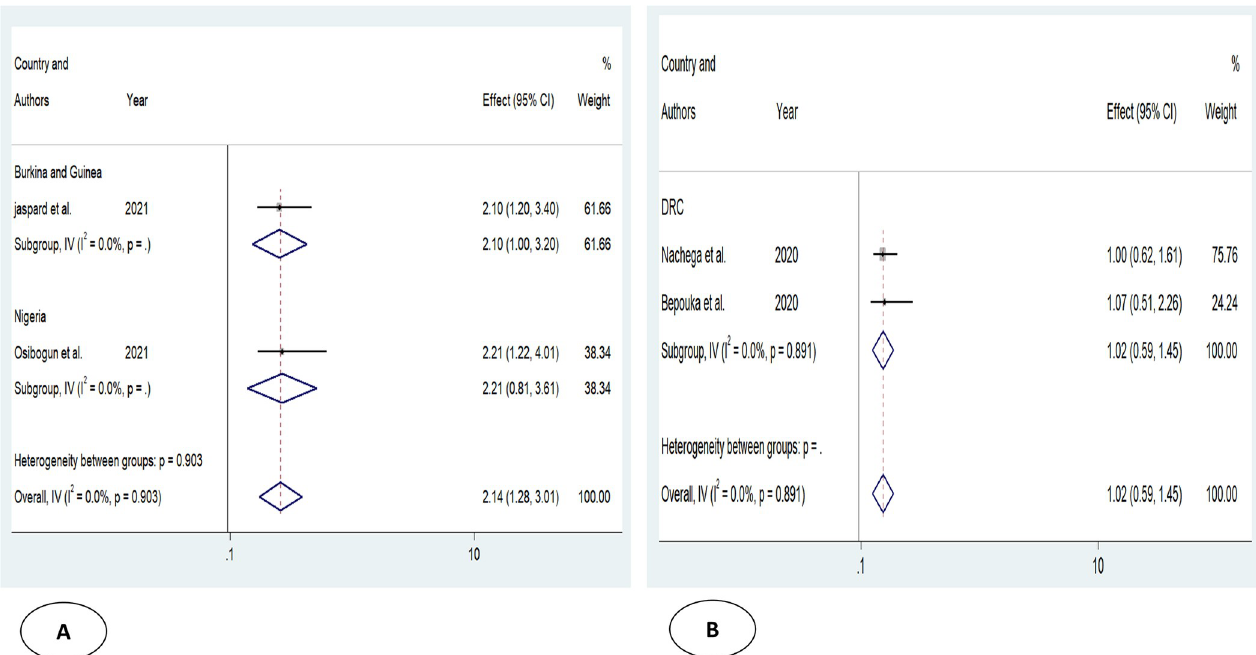
Fig 5. Forest plot showing the estimate for the effects of hypertension on COVID-19 mortality. Forest plots of studies using A. Odds ratio, B. Hazard ratio.